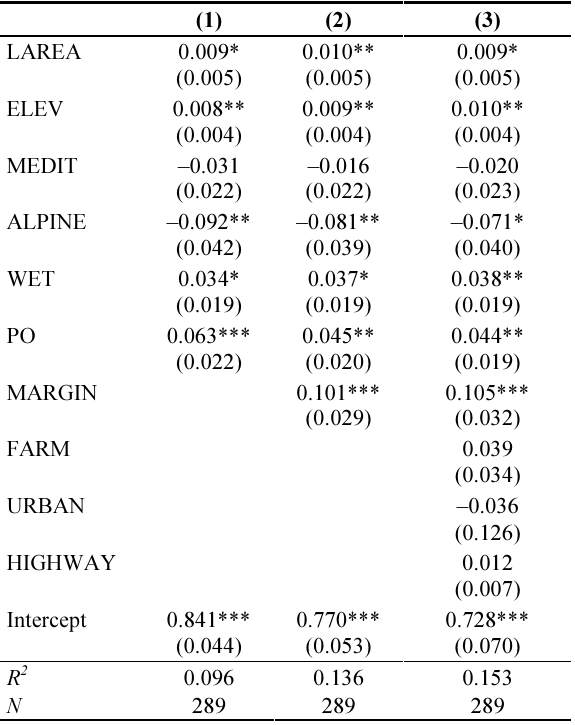
Table 2. Share of habitat area with conservation status not compromised: OLS estimates (robust standard errors in